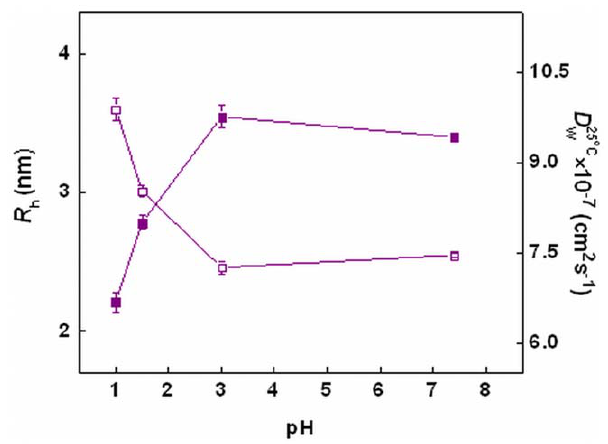
Figure 8. Dynamic light scattering. Effect of pH on hydrodynamic radii (- % -) and translational diffusion coefficient (- & -) of chymopapain. Protein concentration was 40 m M.